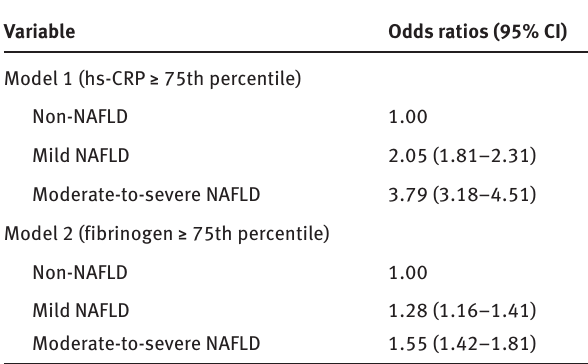
Table 2: Multiple logistic regression for the association between NAFLD and inflammatory markers (hs-CRP and fibrinogen) Variable Odds ratios (95% CI)